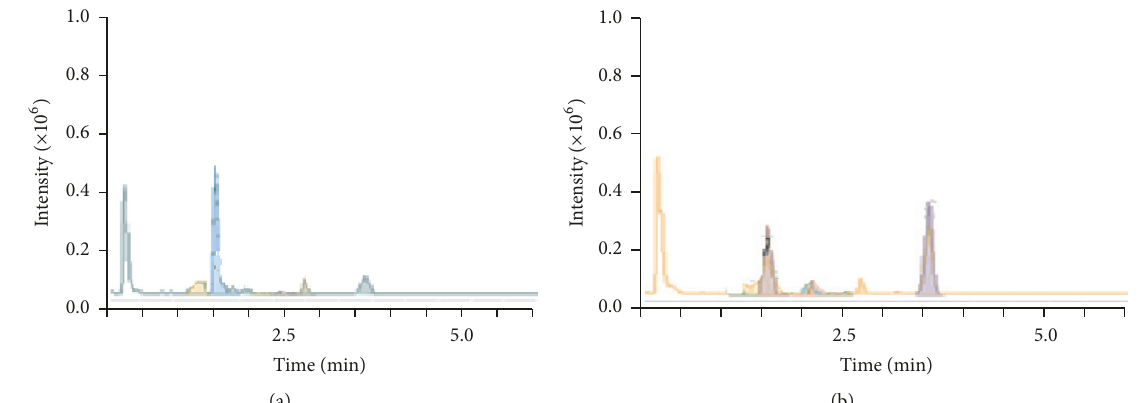
Figure 3: LC-MS/MS chromatogram of metabolites biofluid on day 1 (a) and day 6 (b).